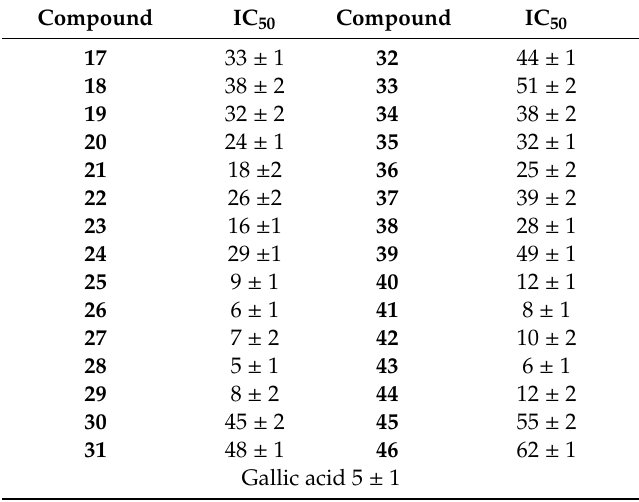
Table 3. Comparison of the DPPH assay results of chalcones ( 17 – 31 ) and dihydropyrazoles ( 32 – 46 ) (IC 50 values in µ g /